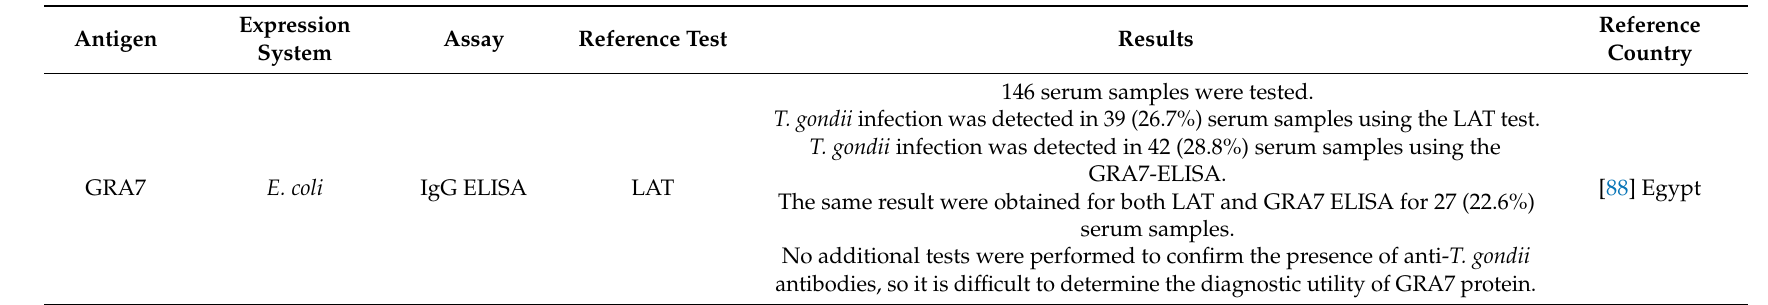
Table 10. Recombinant antigens used in detection of anti -T. gondii antibodies in donkey serum